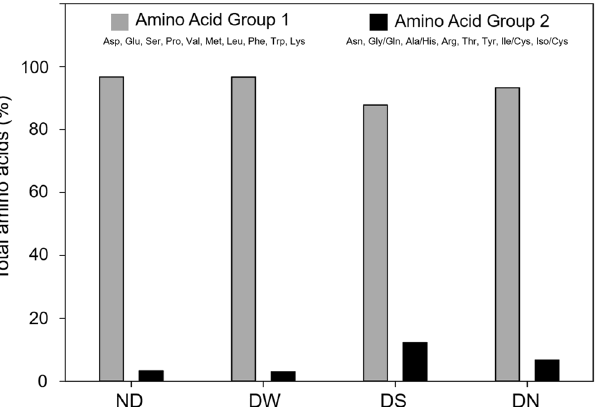
Figure 8. Total percentage of free amino acids quantified in ND, DW, DS, and DN treatments. The DS treatment showed the highest loss of amino acids of group 2 (GLY/GLN, ALA/HIS, ARG, THR, TYR, and Iso/ CYS) involved in the mechanism of restructuration of